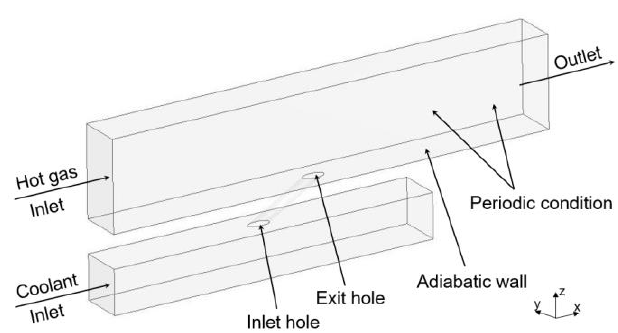
Figure 1. Geometry and computational domain.